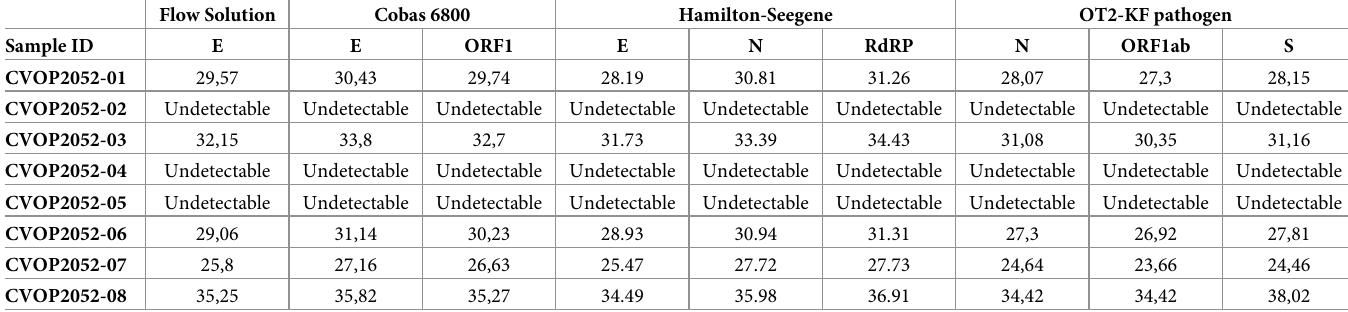
Table 2. Comparison of four different platforms used for SARS-CoV-2 detection from external quality control samples, including our OT2-KF circuit. Every plat- form has its own targets and primers. Flow Solution Cobas